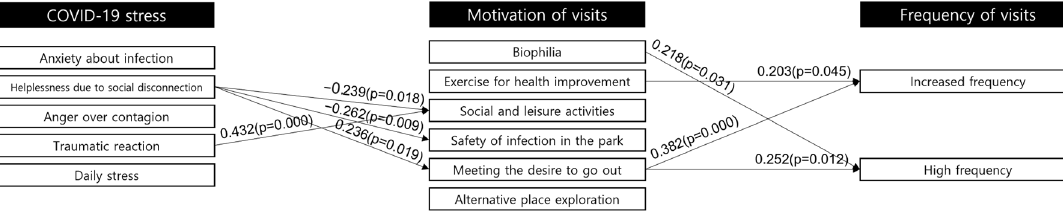
Figure 4. Causal relationships between stress, motivation for, and frequency of park visits .